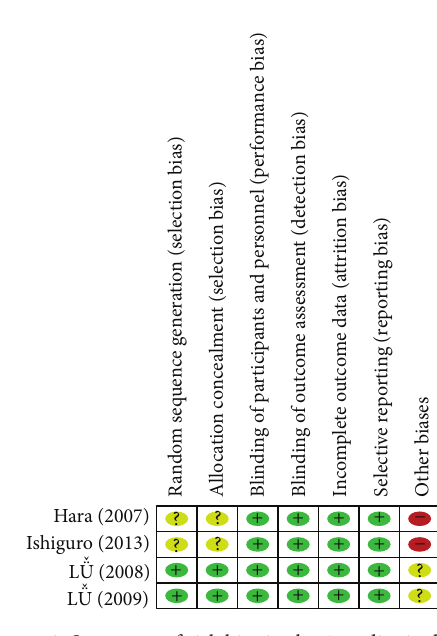
Figure 3: Summary of risk bias in the 4 studies